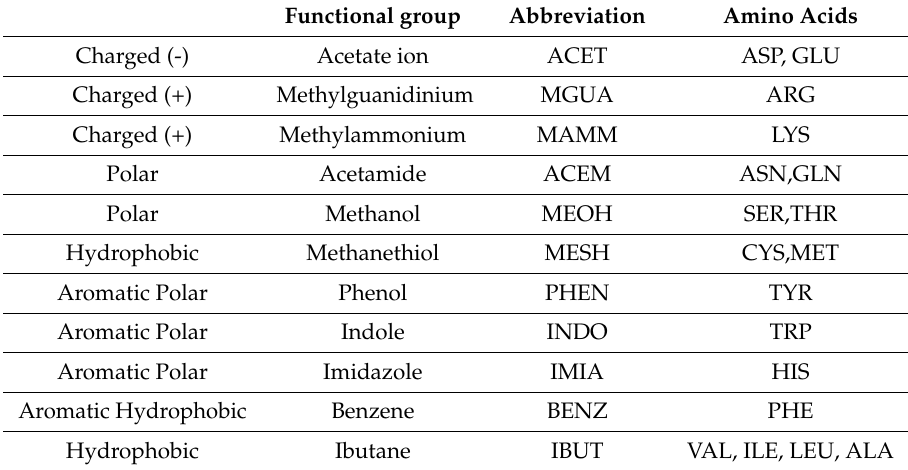
Table 1. Relationship between the functional groups used and amino acids.